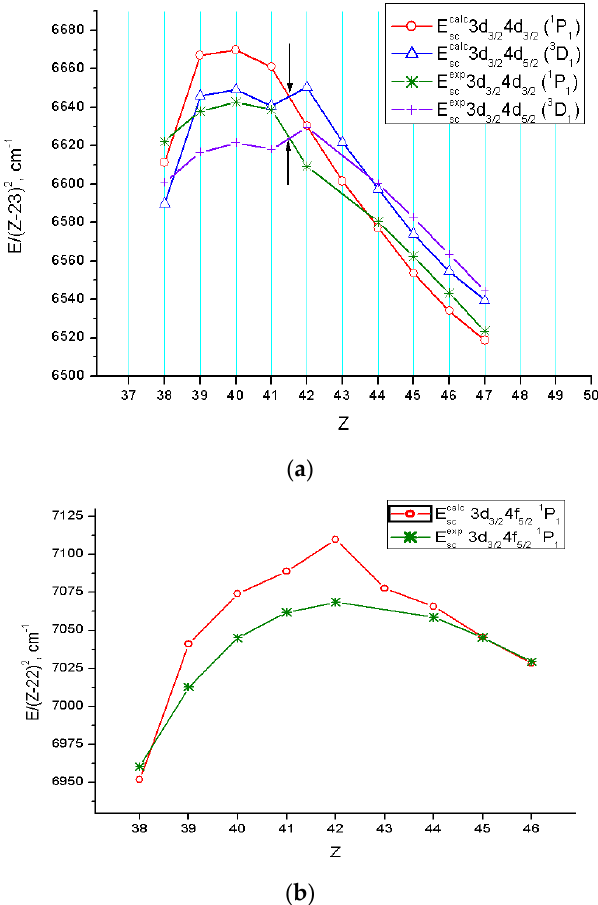
Figure 2. ( a ) Theoretical and experimental crossing of low working 3d 3/2 4d 3/2 [J = 1] energy level with 3d 3/2 4d 5/2 [J = 1] energy level in Ni-like sequence, shown by scaled energy values along Z .; ( b ) Features of theoretical upper working level 3d 3/2 4f 5/2 [J = 1] , shown by scaled energy along Z in comparison with correspondent experimental data.